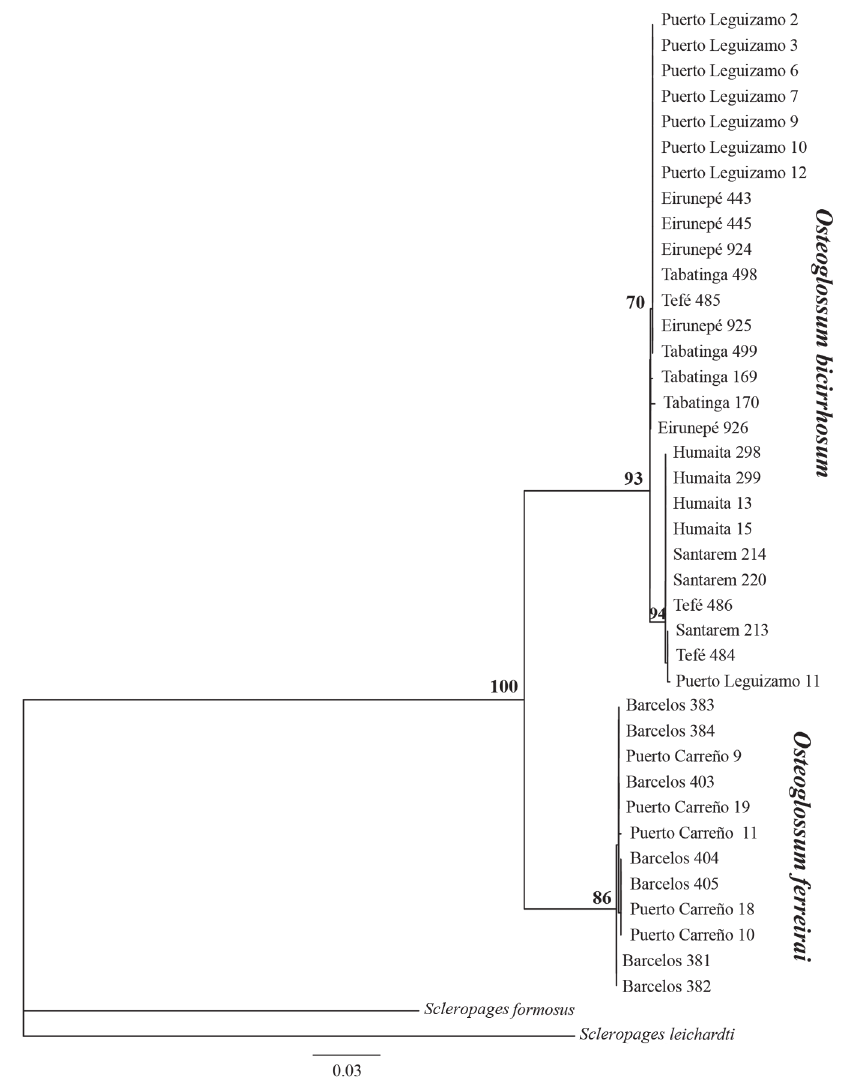
Fig. 2. Maximum likelihood phylogenetic hypothesis of relationships of Osteoglossum individuals representing the species O. bicirrhossum and O. ferreirai .